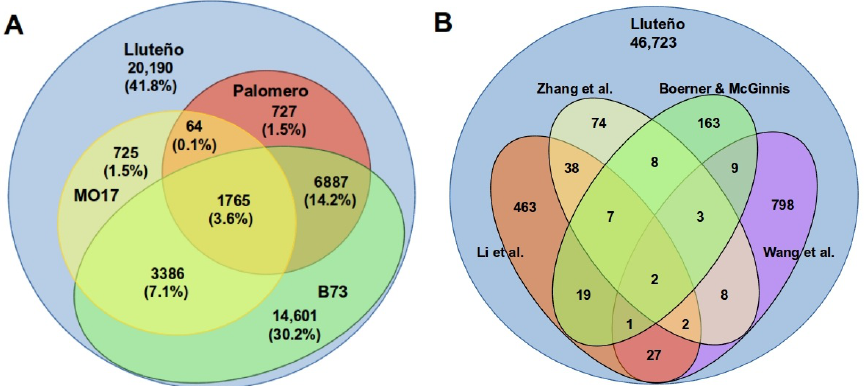
Figure 3. ( A ) Comparative RNomics of Lluteño lncRNAs in relation to four different maize hybrids with genome sequence available: MO17, Palomero and B73; ( B ) Lluteño lncRNAs also available